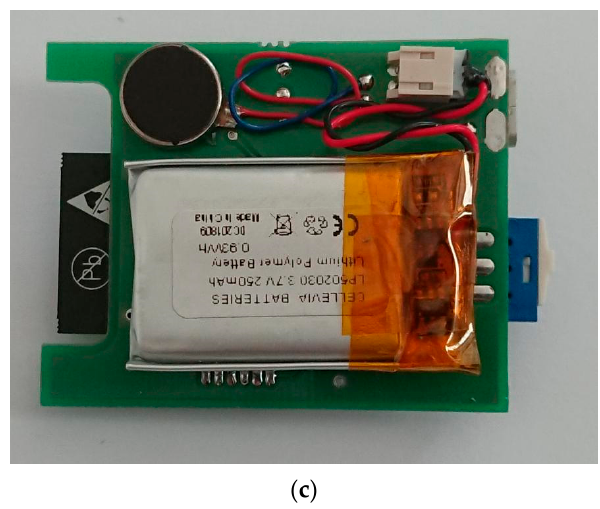
Figure 3. ( a ) Wearable device; ( b ) its internal construction top (R—radiofrequency module, ESP32-WROOM-32); ( c ) bottom view.